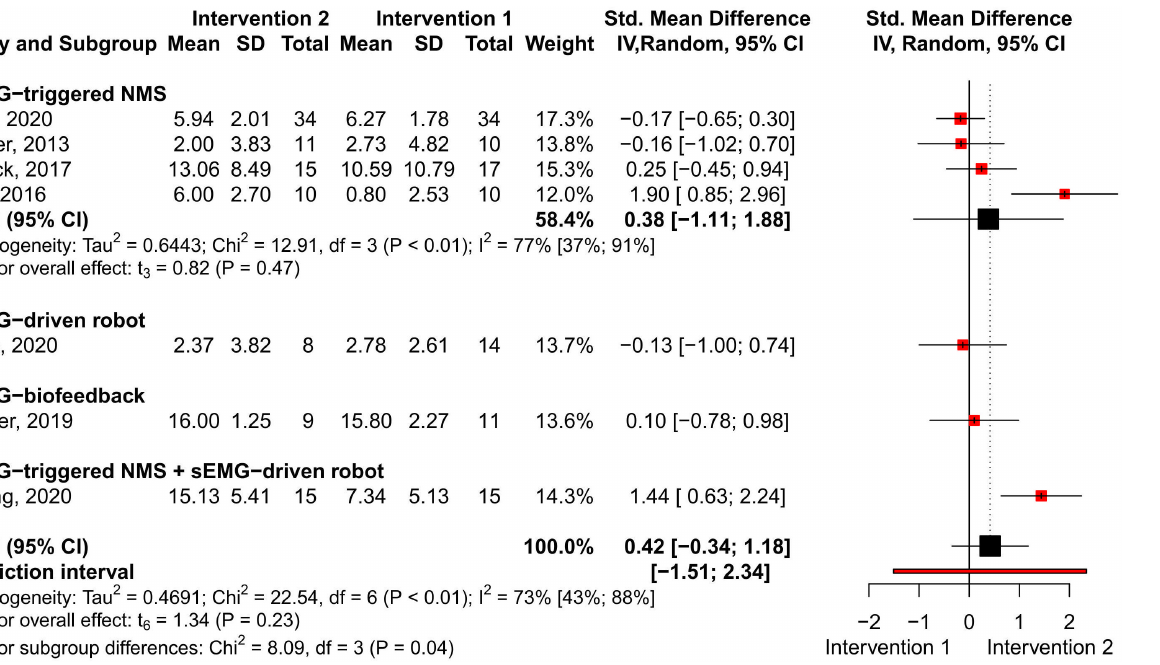
FIGURE 6 | Meta-analyses of the effect of sEMG intervention versus another sEMG intervention on total FMA-UE score. s-EMG, surface electromyography; NMS, neuromuscular stimulation; +, combine with.